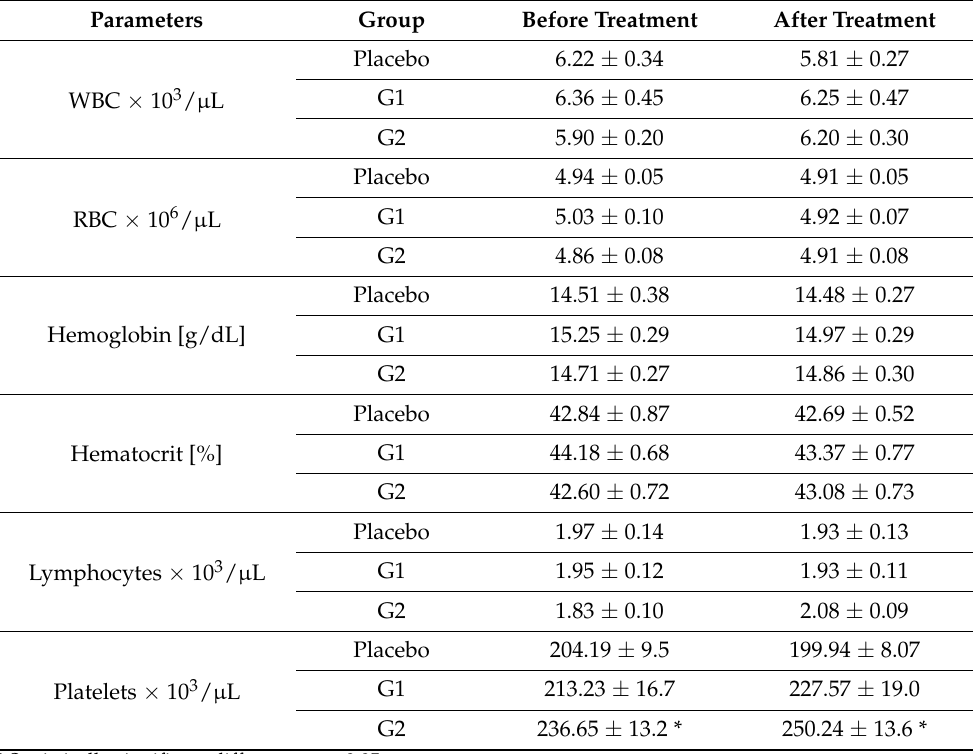
Table 2. Hematological parameters of study population (mean ± SEM).